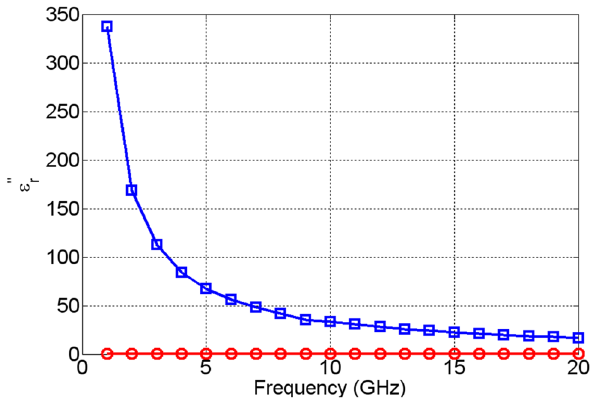
" Figure 16. Extracted ε r of TiO 2 in OFF state (red circles) and in ON state (blue squares).